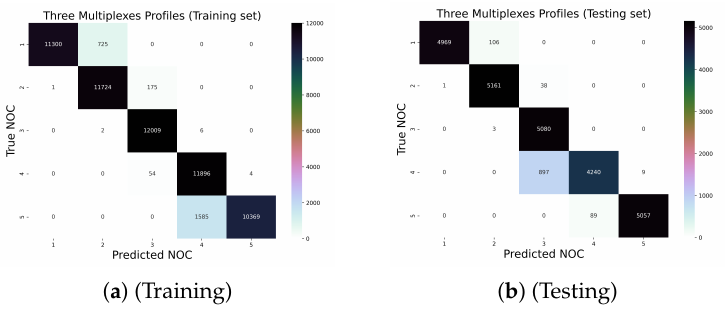
Figure 27. TAWSEEM: confusion matrix (three multiplexes profiles).